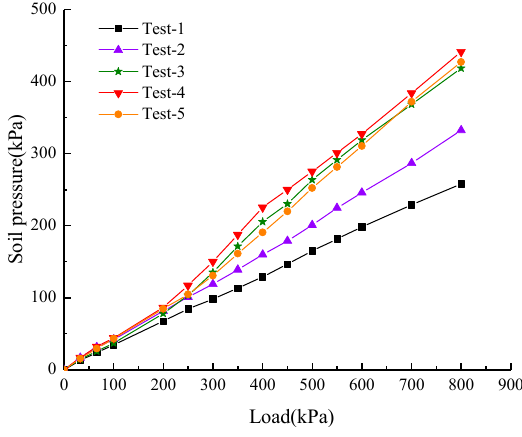
Figure 5. Curve of load–soil pressure.